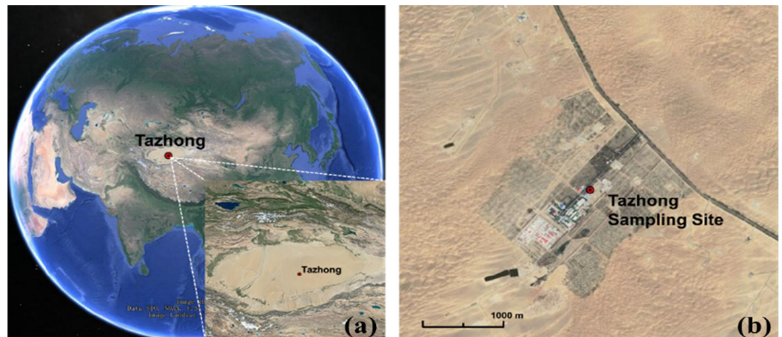
Figure 1. Sampling site in Tazhong, Xinjiang Uygur Autonomous Region, China (Source: Google Earth). ( a ) The overview of sampling site. ( b ) The zoom-up of sampling